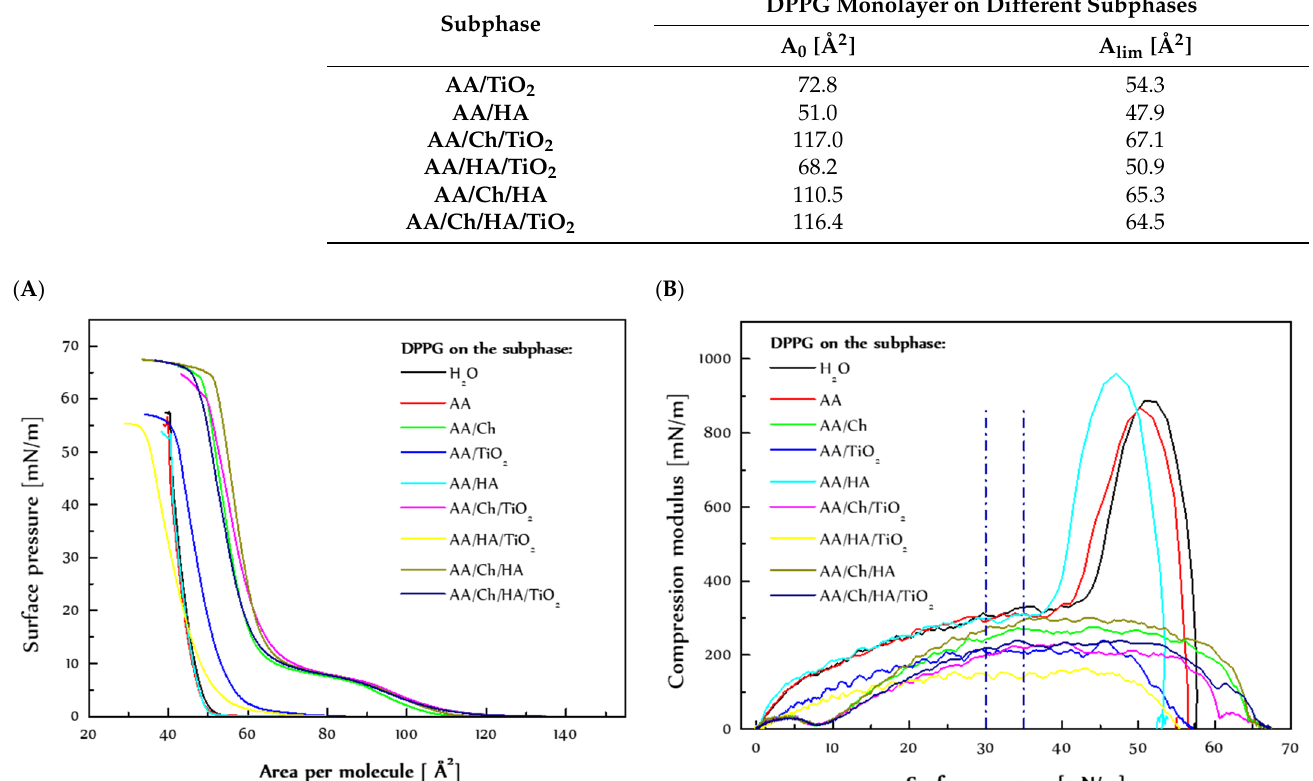
Figure 1. ( A ) π = f(A) isotherms obtained by means of the Langmuir technique and determined based on them ( B ) C S − 1 = f( π ) relationships for the DPPG monolayer on individual subphases.